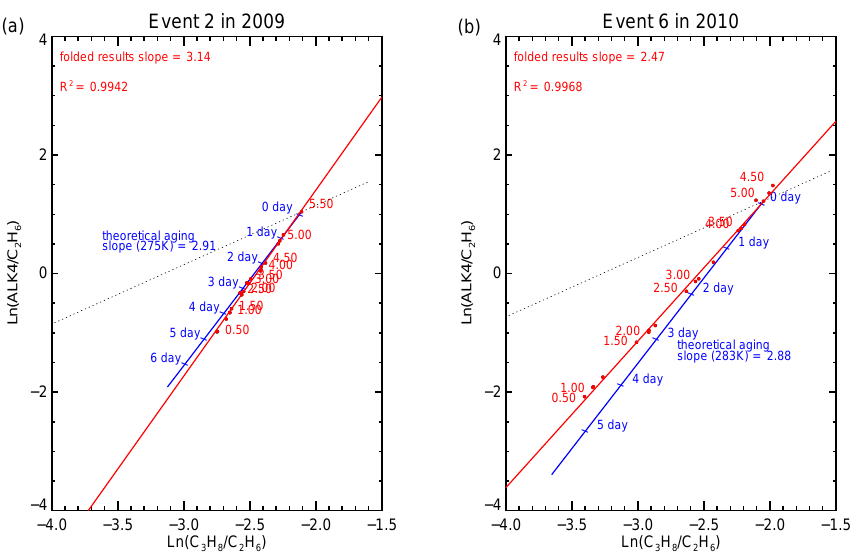
Fig. 5. Relationship between the natural logarithms of [ALK4]/[ethane] versus [propane]/[ethane] in folded results during transport of event 2 (a) and event 6 (b) . Folded results (UFQs) are shown in red dots, with labels indicating the upwind time at which the simulated data were obtained. Red solid lines indicate the two-sided regressions for folded results, and the slope and R 2 values of the regressions are given in the top-left corner of each plot. The two lines initiating from the youngest data point represent, respectively, mixing of background air containing negligible concentrations of ALK4 and propane (dotted black line) and theoretical oxidation by OH (solid blue line). Marks on the theoretical decay line provide estimates of decay rate at an average ambient temperature in folded results.